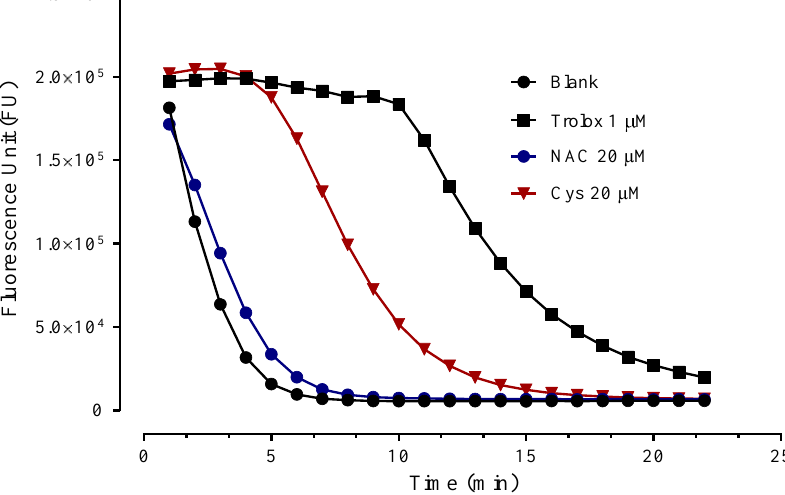
Figure 8. ORAC assay: radical scavenging of Cys, NAC and Trolox.